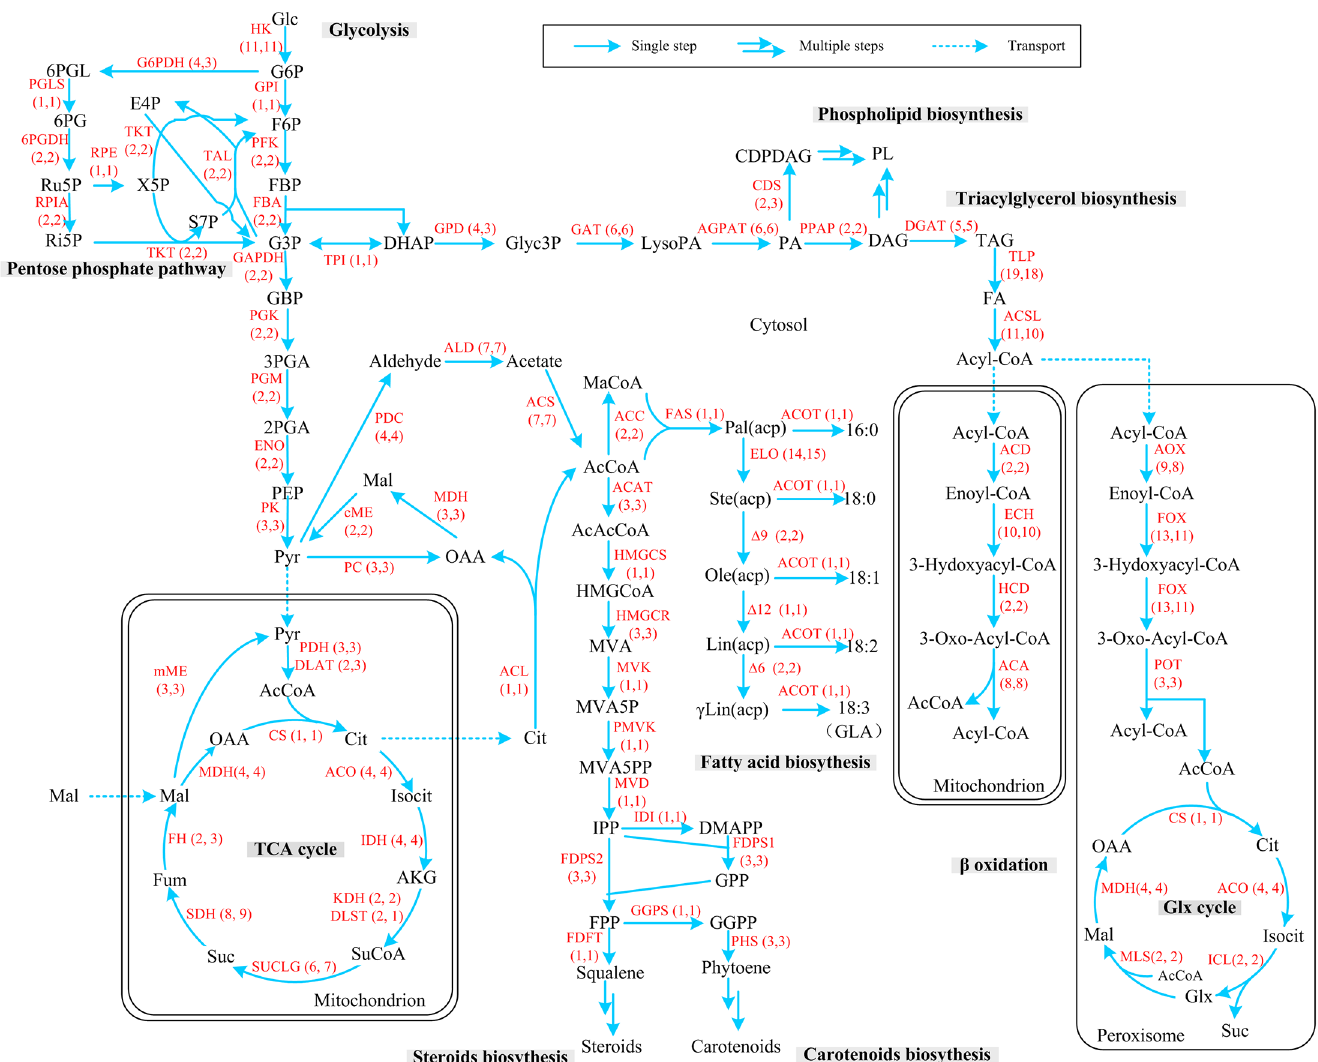
Fig 3. Reconstruction of central carbon and lipid metabolism pathways of M . circinelloides WJ11 and CBS 277.49. The metabolic network that was reconstructed from the KEGG pathway included glycolysis, pentose phosphate pathway, TCA cycle, fatty acid synthesis, sterodis and carotenoids biosynthesis, triacylglycerol and phospholipid biosynthesis, lipolysis β -oxidation and glyoxylate cycle. The number in parentheses indicated the number of genes encoding the enzymes in WJ11 and CBS 277.49, respectively. The abbreviations are included in S1 and S2 Tables.